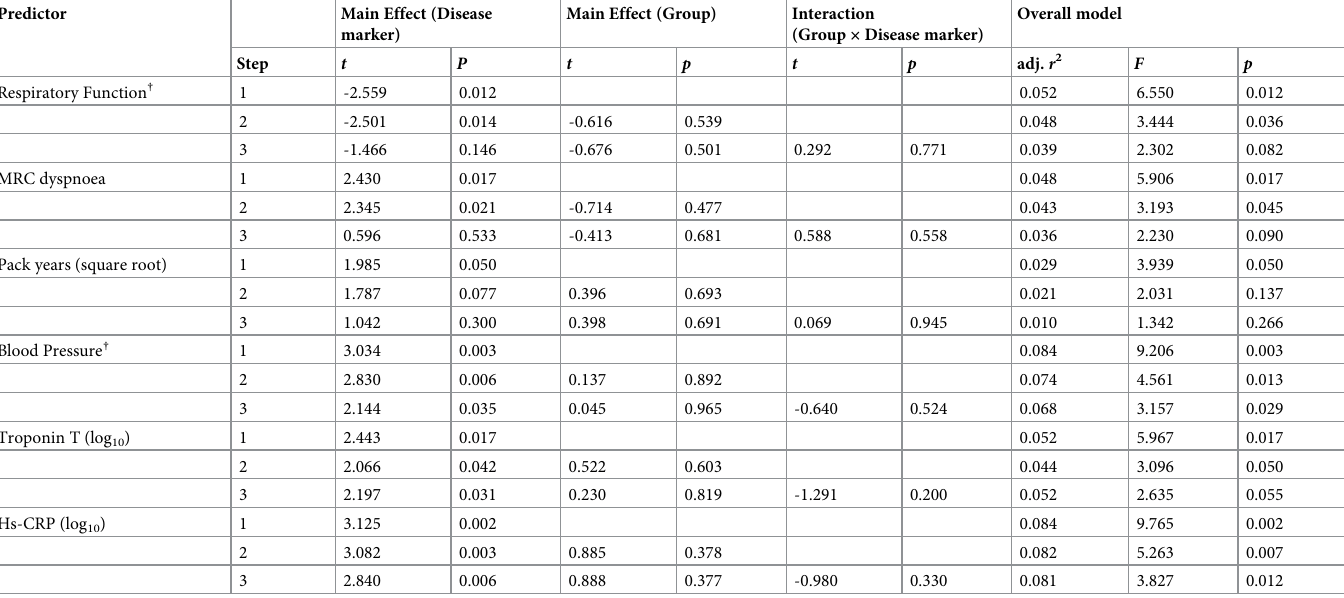
Table 3. Single variable models (hierarchical linear regression)–WMH volume.